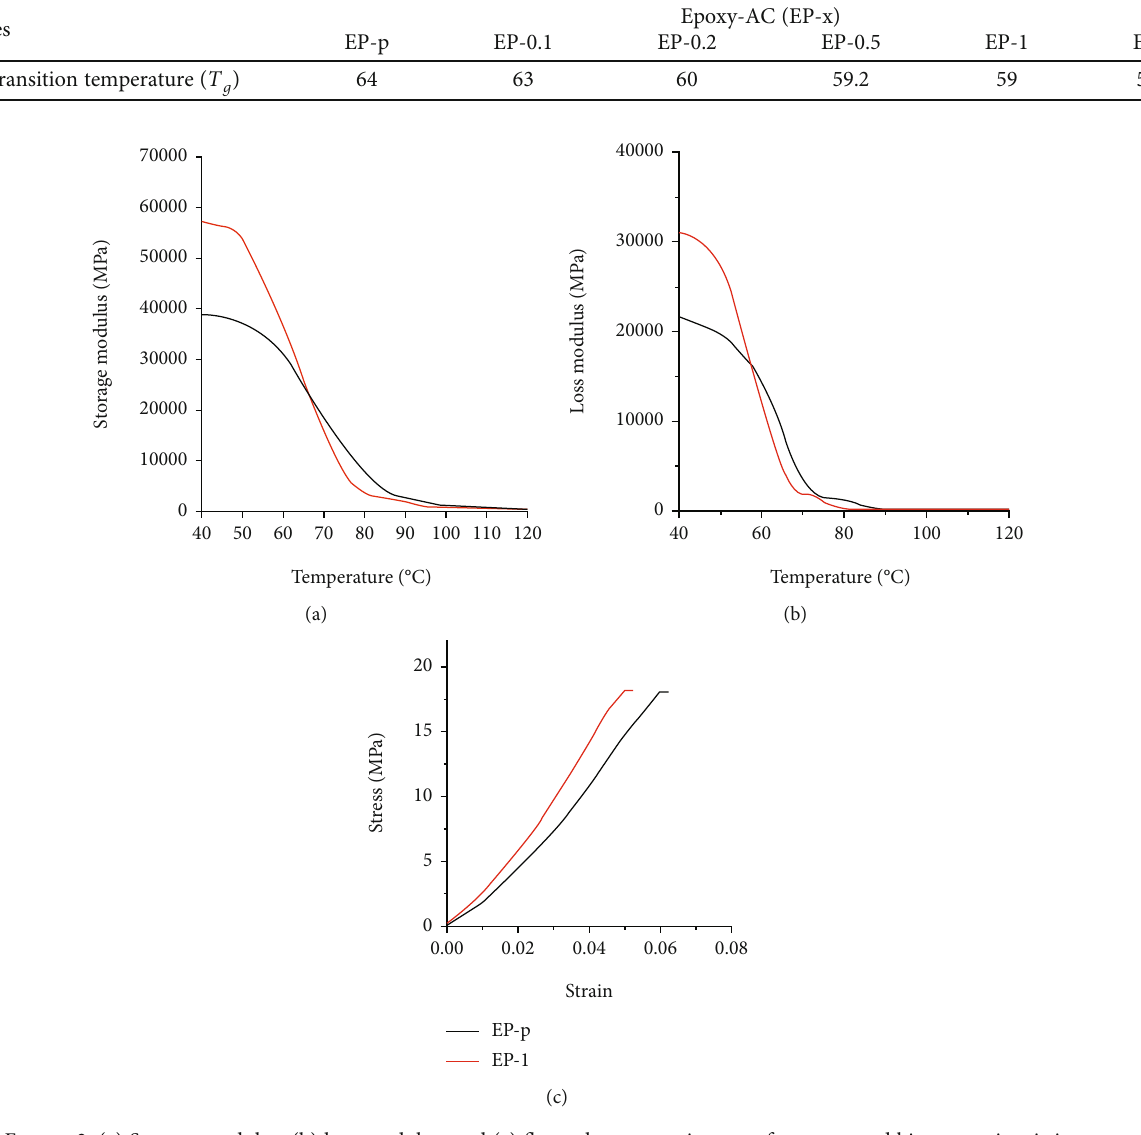
Figure 2: (a) Storage modulus, (b) loss modulus, and (c) fl exural stress-strain curve for epoxy and biocomposite vitrimers.